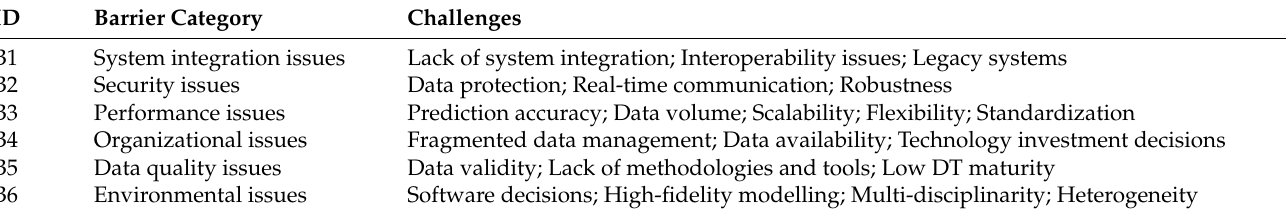
Table 2. Most crucial technical barriers impeding DT implementation. We endorse and apply the categories established by Perno et al. [65] for the process industry and provide a summary of topics causing difficulty in the energy